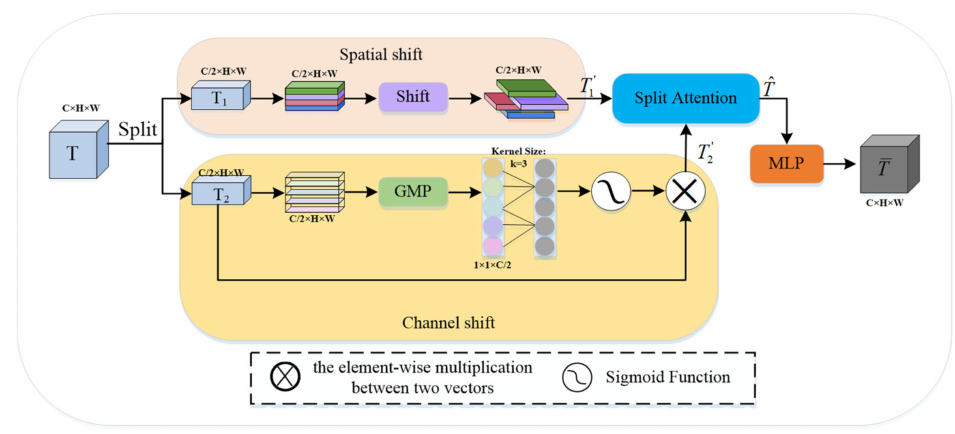
Figure 3. Dual-channel Shift MLP